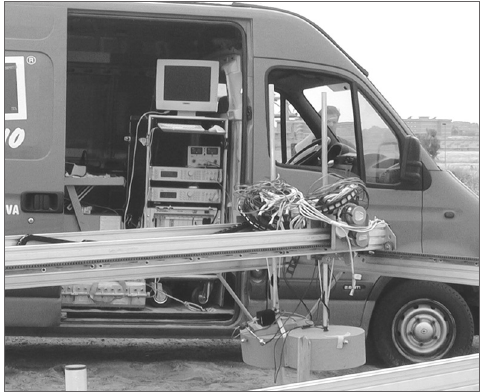
Fig. 1. The rack of the GPR inside the van during da- ta acquisition campaign.